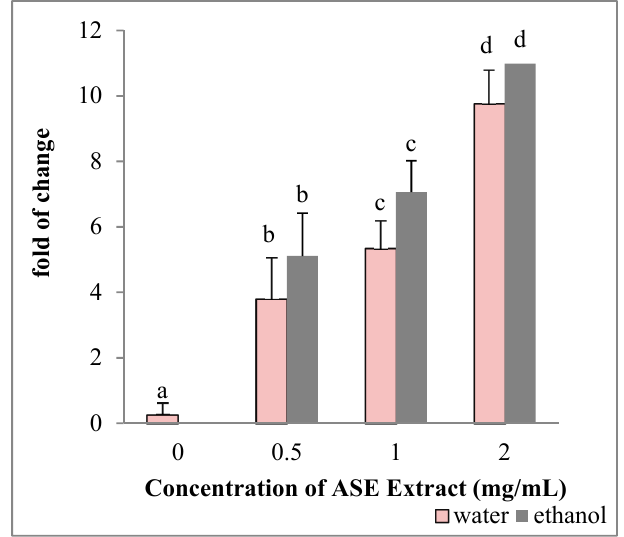
observed at the highest concentration (2 mg/mL) of ethanolic or water extracts (Figures 6 and 7).